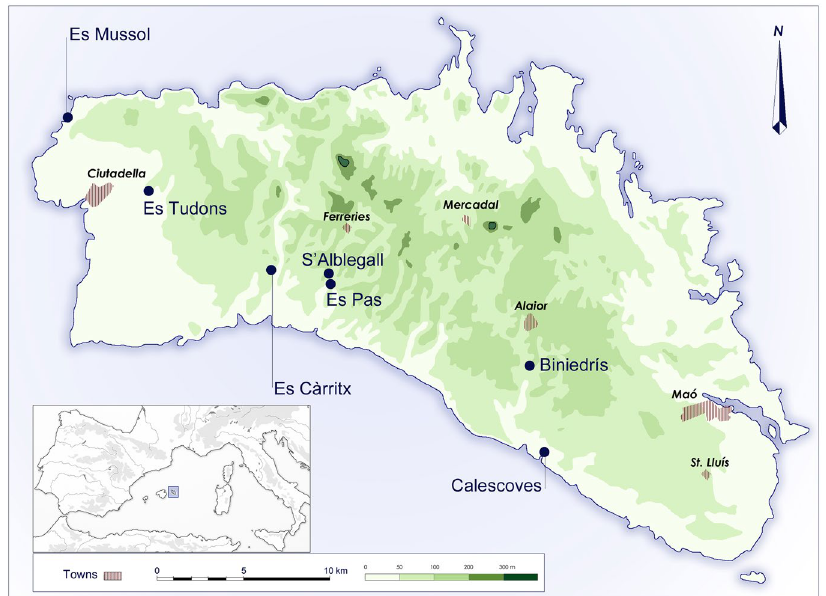
Figure 1. Location of the funerary sites mentioned in this